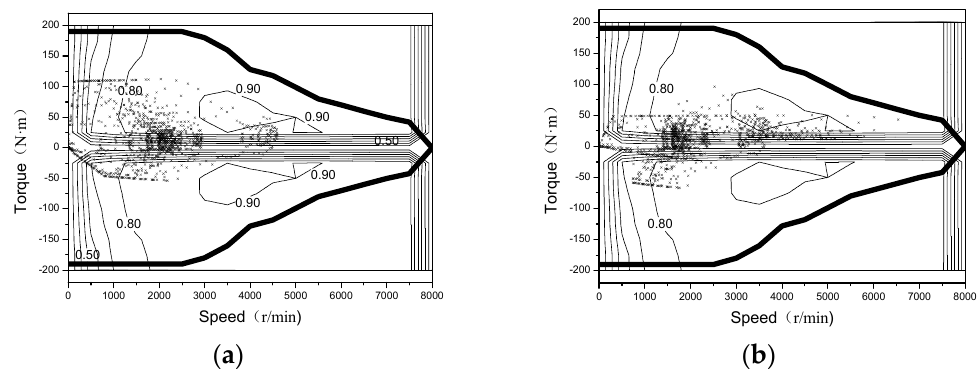
Figure 14. Motor operating point comparison (UDDS). ( a ) Fixed ratio transmission. ( b ) Two-speed planetary transmission.